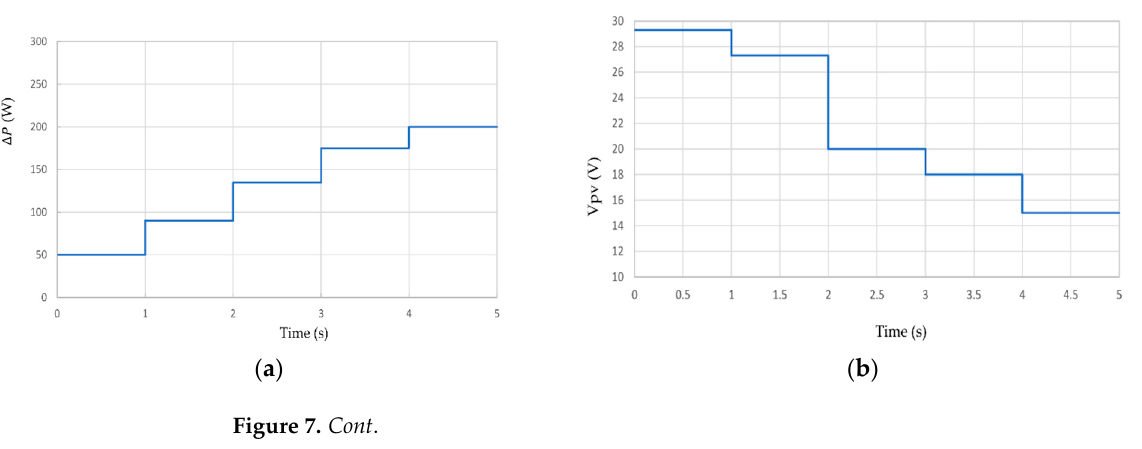
Figure 6. The regression diagram for trained data.